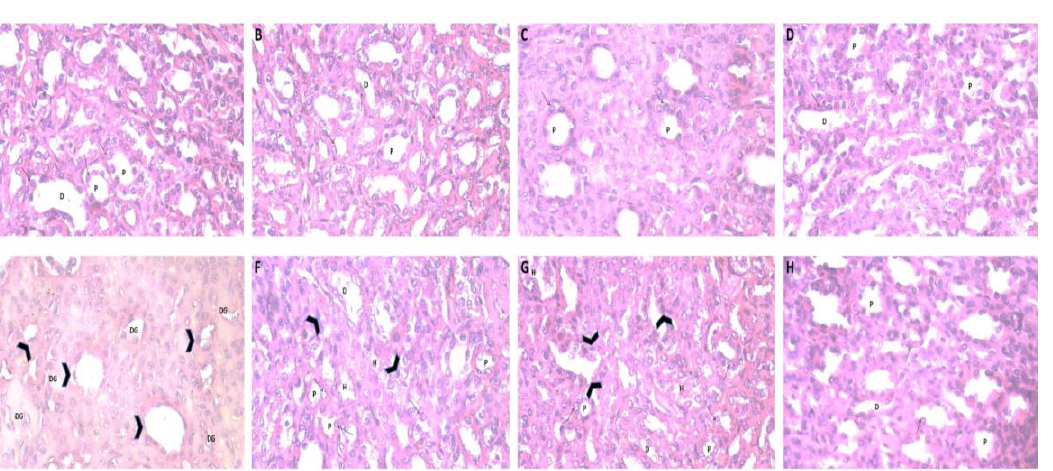
Fig. 3. Photomicrographs of histological sections of glomerular structure of rats’ renal cortex by Hematoxylin and eosin. A: Control group; B: Negative control treated with sitagliptin; C: Negative control treated with oleuropein; D: Negative control treated with combination of sitagliptin and oleuropein, all can be seen with normal glomerular tuft (G), normal proximal convoluted tubules (P); E : Cisplatin treated rats have shrunken degenerated glomerular tuft (G) with abundant hemorrhage, atrophied tubules (stars). F: Cisplatin+sitagliptin treated rats show the regaining of the vasculature of the glomeruli and the architecture of the tubular cells which show rounded vesicular central nuclei, still there is an abundance of hyaline cast. G : Cisplatin+ oleuropein treated rats show shrunken glomerular tuft that has few nuclei and dilated Bowman's space (B), proximal tubular cells recovered their cubical cells and vesicular nuclei as well as lumen clear from cast. H : Cisplatin+ sitagliptin+ oleuropein treated group show Malpighian renal corpuscle containing glomerulus (G) and non- dilated Bowman's space (B), normal proximal convoluted tubules (P) with vesicular nuclei.